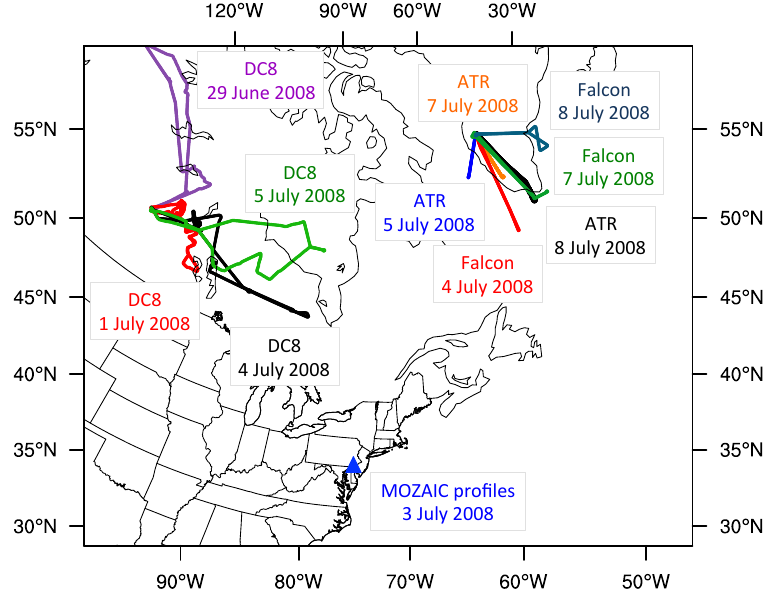
Fig. 1. Map of the WRF-Chem domain and the flights conducted as part of POLARCAT used to evaluate the model. The NASA DC8 flights are shown in purple (29 June), red (1 July), black (4 July) and green (5 July). The ATR-42 flights are shown in blue (5 July), orange (7 July), and black (8 July). The Falcon-20 flights are shown in red (4 July), green (7 July), and light blue (8 July). The location of the two MOZAIC profiles during flights in and out of Philadelphia, Pennsylvania on 3 July is shown by the blue triangle.